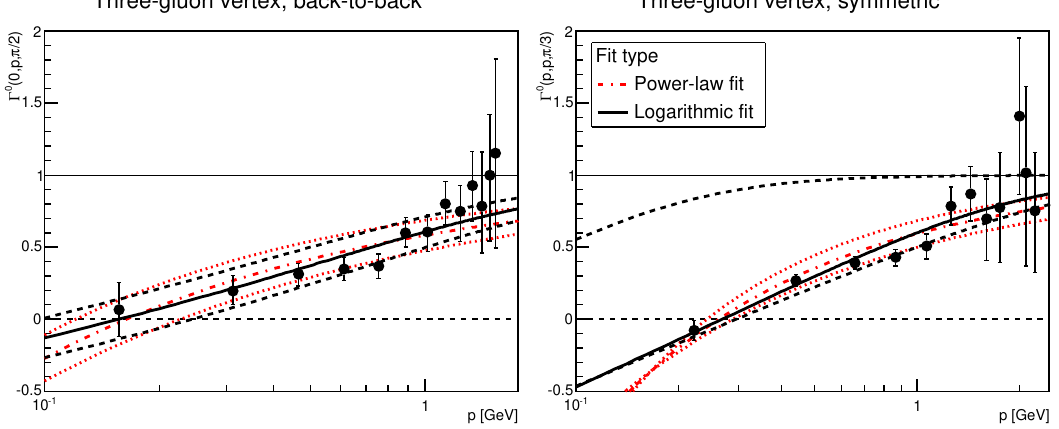
Figure 9: Power-law fits and logarithmic fits compared to the data for the four- dimensional case with the largest physical